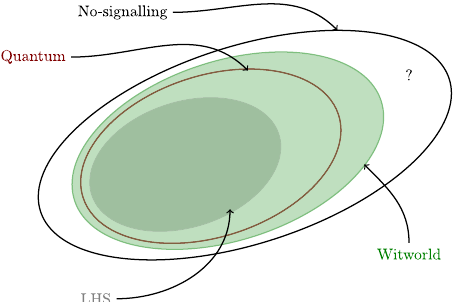
Fig. 3 Pictorial representation of the sets of assemblages in steering scenarios. The set of classical (Local Hidden State) assemblages is depicted by the grey ellipse. The set of quantum assemblages is depicted by the red-bordered region. The set of Witworld assemblages is depicted by the green transparent region. The set of no-signalling assemblages is depicted by the black- bordered ellipse. The set of Witworld assemblages strictly contains the quantum set, which strictly contains the LHS set. The set of no- signalling assemblages contains the Witworld set, and an open question (pictorially depicted by the question mark) is whether this inclusion is